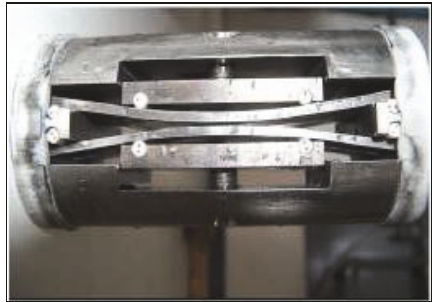
Figure 5: Specimen